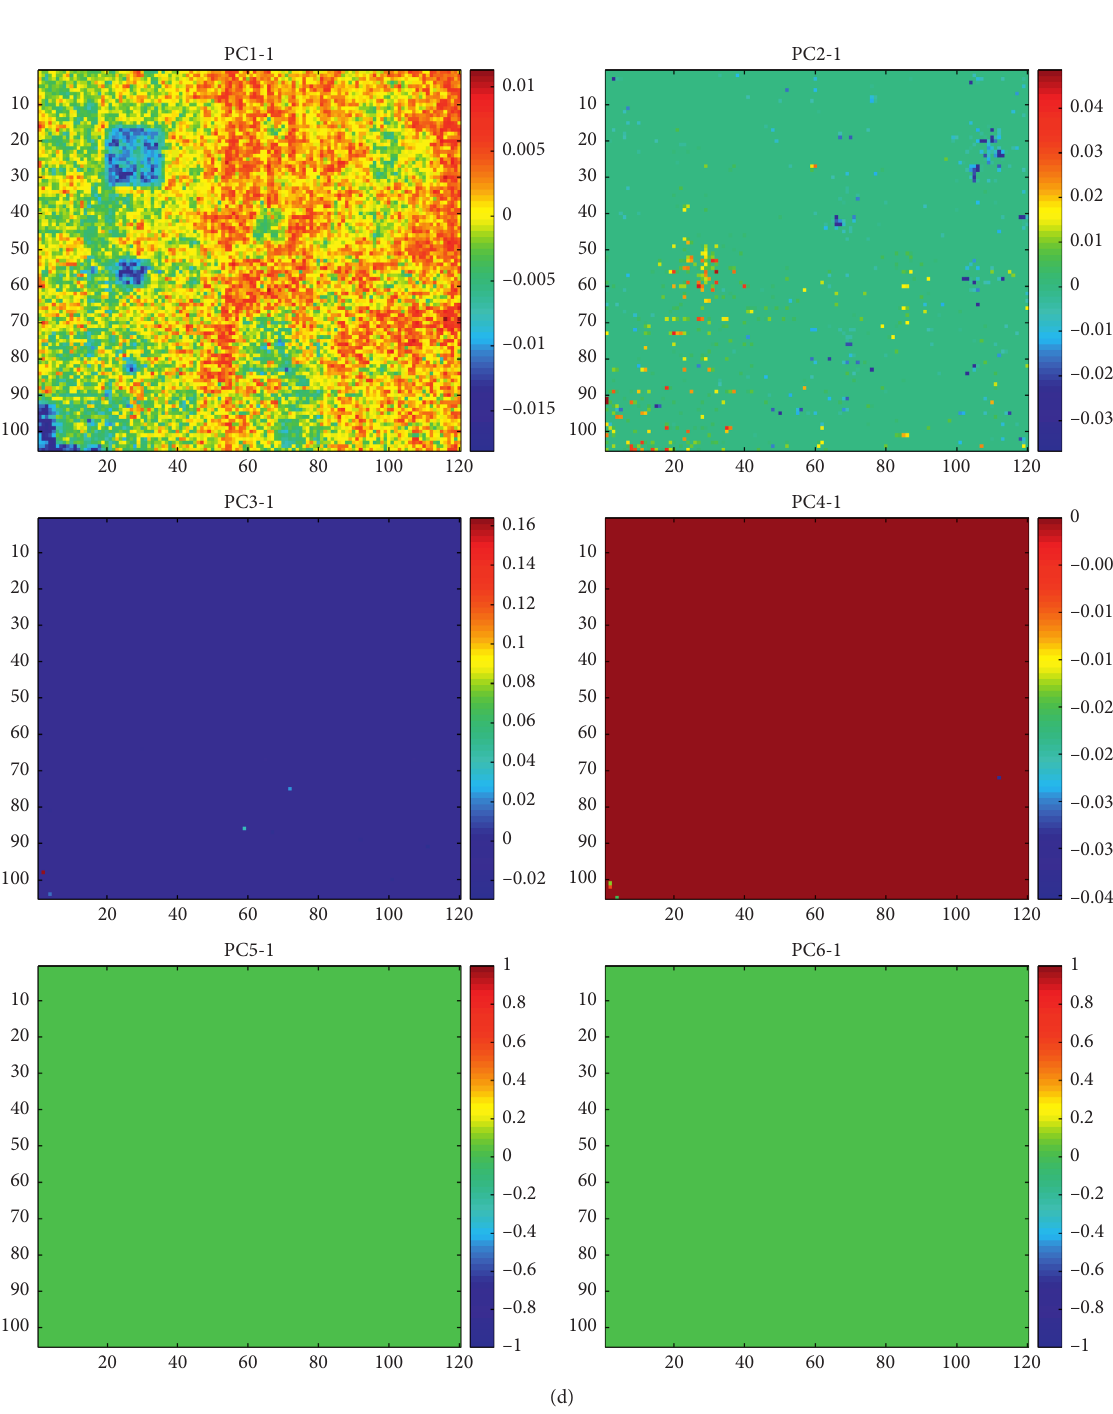
Figure 5: Results: (a) PCT, (b) SPCT, (c) MWPCT, and (d)